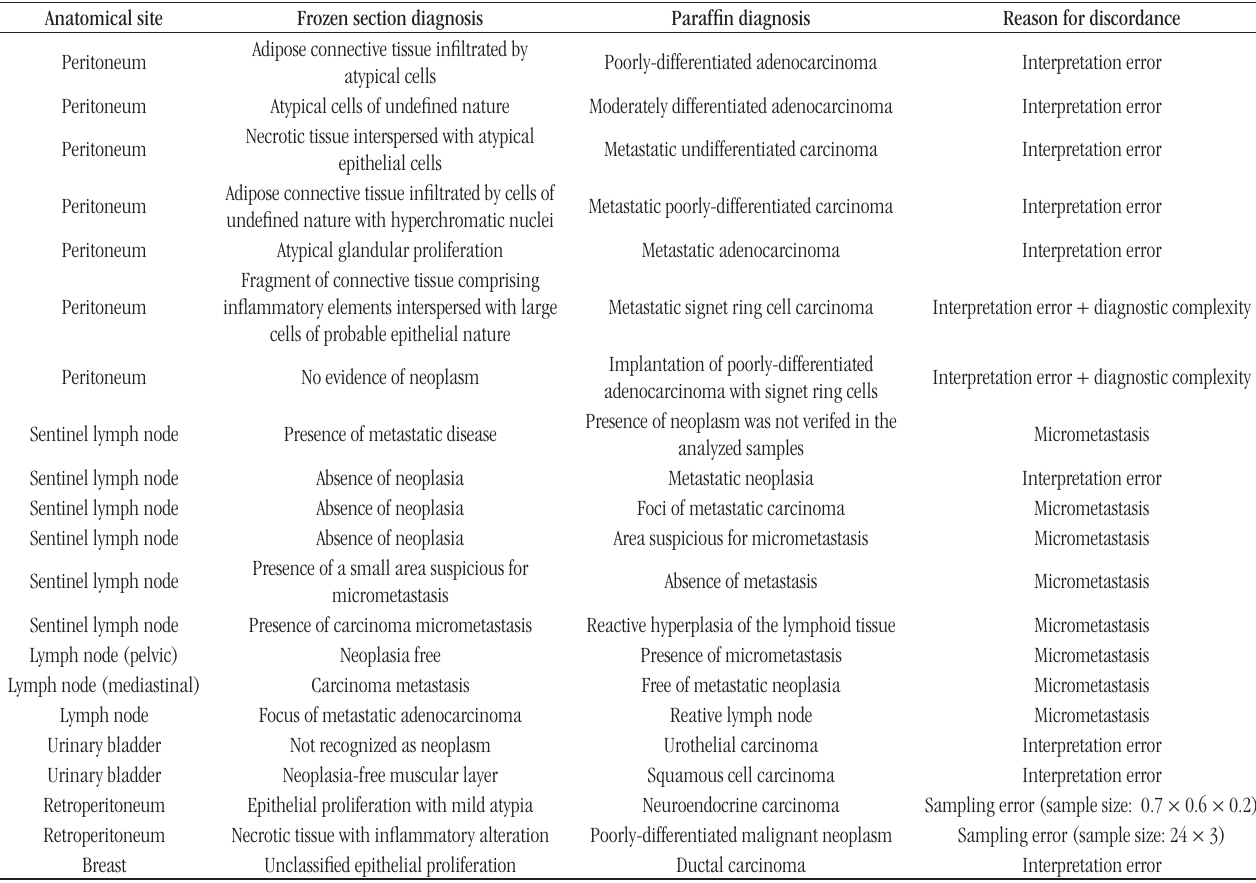
taBLE 4 − Causes of discordance found in re-testing of other